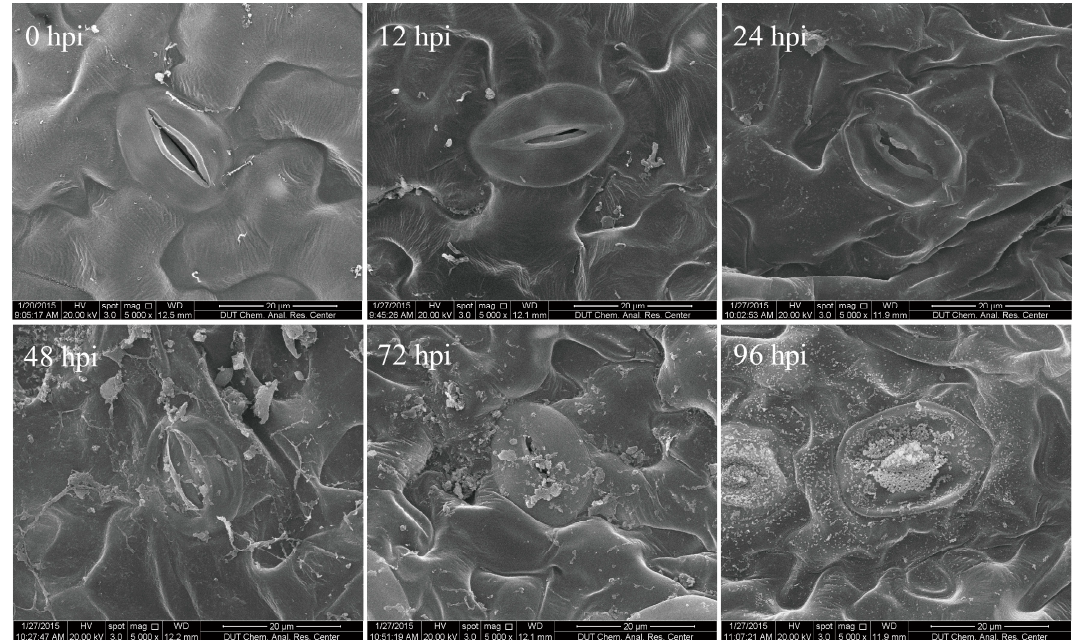
Figure 1. Preparation of Fusarium proliferatum -infected tomato leaves ( Solanum lycopersicum ) for transcriptome analysis. Leaves were obtained 0, 12, 24, 48, 72 and 96 h after inoculation (hpi) with a conidial suspension of F. proliferatum .